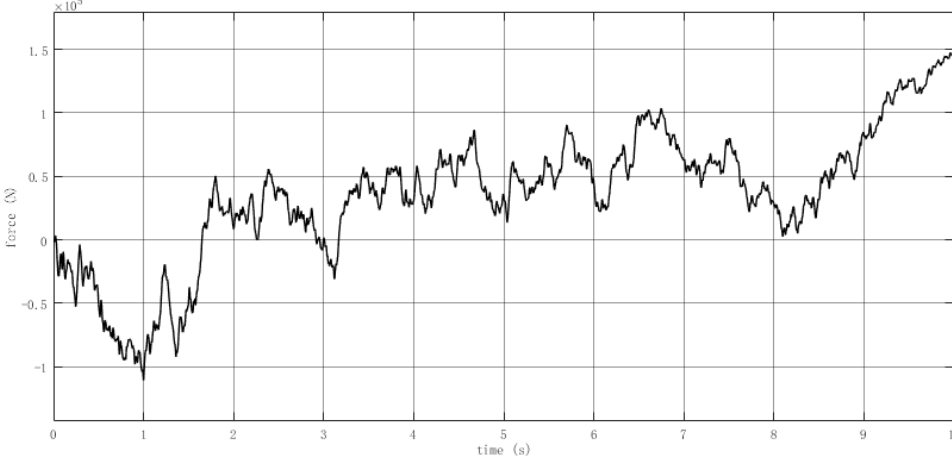
Figure 5. Identification output signal diagram of the system.